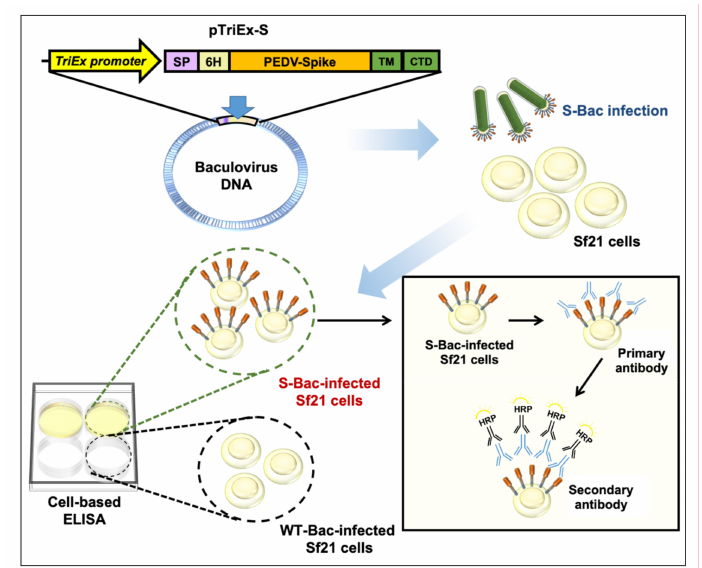
Figure 1. Schematic showing how S-Bac-infected cells are used for cell-based ELISA. S-Bac was used to infect Sf21 cells to display S on the cell membrane. These S-displayed cells, together with WT- Bac-infected cells (as control cells), were used to establish a cell-based ELISA system. The presence of anti-S primary antibodies is detected by horseradish peroxidase (HRP)-conjugated secondary antibody and can be quantified based on subsequent color